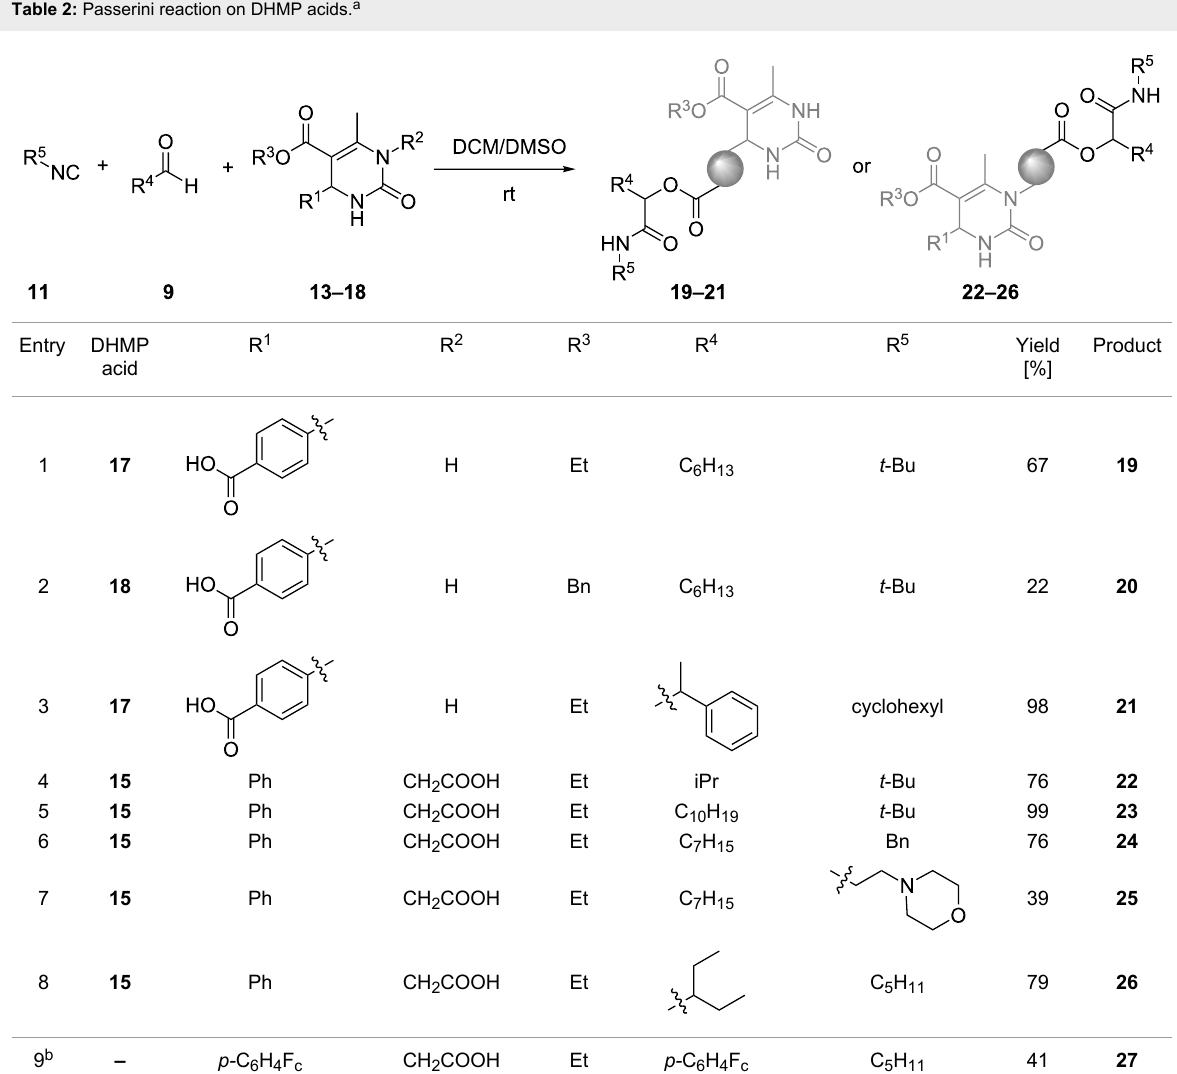
Table 2: Passerini reaction on DHMP acids. a